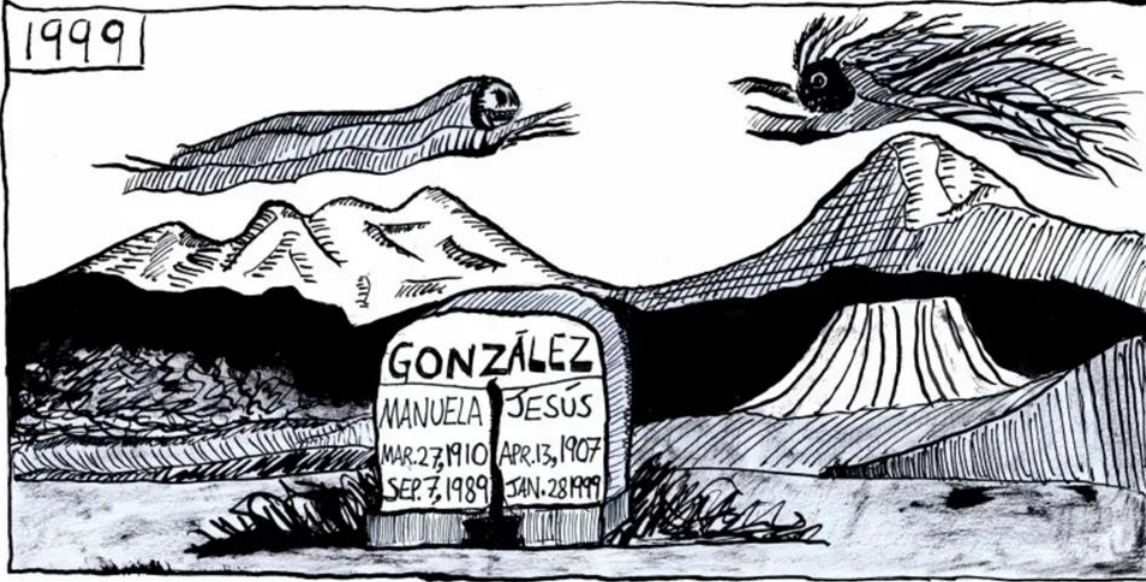
Figure 3: One of the last panels in Breaking Tezcatlipoca which is filled with symbolisms linked to the tragic myth of Popocatépetl and Iztaccihuatl. Chucho and Manuela are buried in view of these